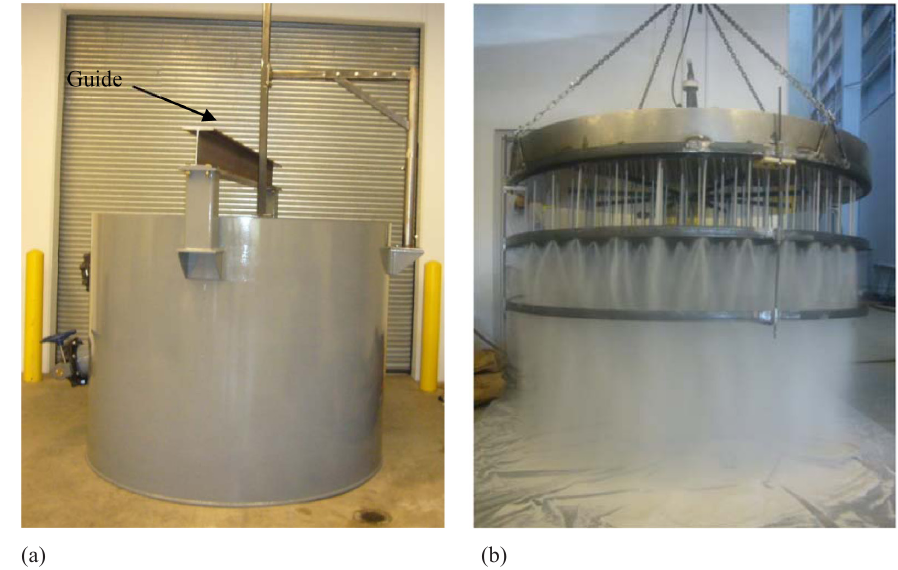
Fig. 1. Soil preparation for model pile tests: (a) Chamber lateral view, (b) sand pluviation